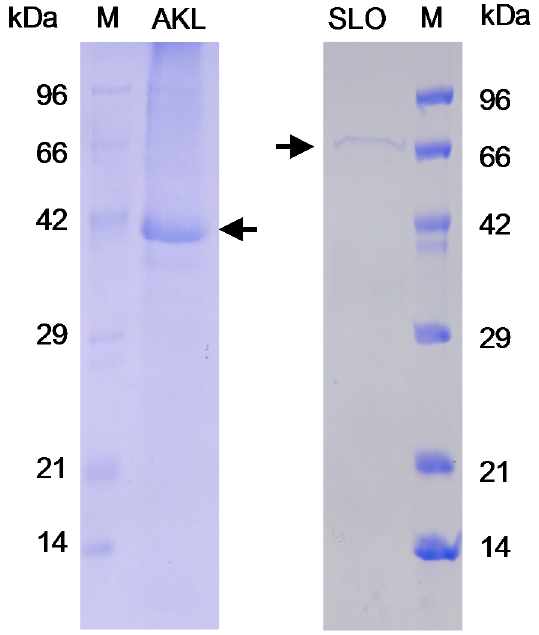
Figure 2. Stable absorbance of hemin chloride and optical detection of SLO-induced hemolysis. ( A ) 1 mL of RBCs ruptured by distilled water (dotted line), or RBCs hemolyzed by SLO (solid line), was mixed with 1 mL HCl (2%) in acetone to convert heme to hemin chloride. Arrow: optimal absorbance (wavelength 510 nm); ( B ) Serially 2-fold diluted SLO was mixed with ruptured RBCs and HCl (2%) in acetone, and absorbance at 510 nm was measured.